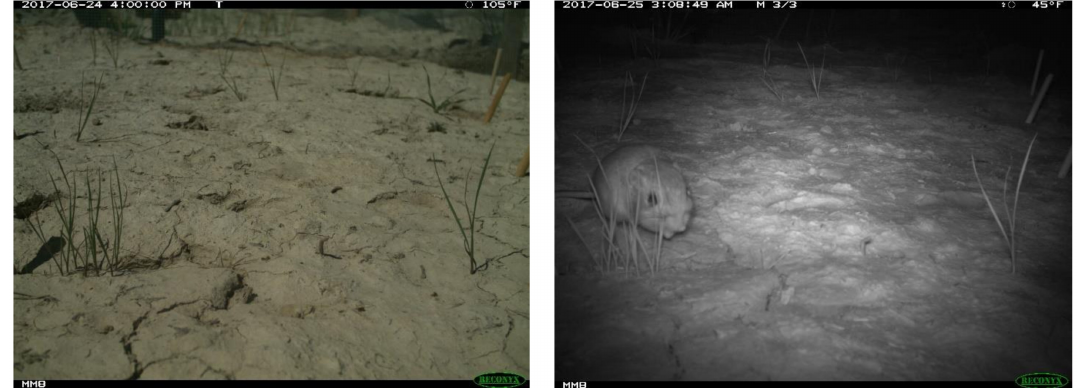
Figure 2. An example of timed ( left ) and motion triggered ( right ) images obtained from a camera trap that were analyzed for seedling height and